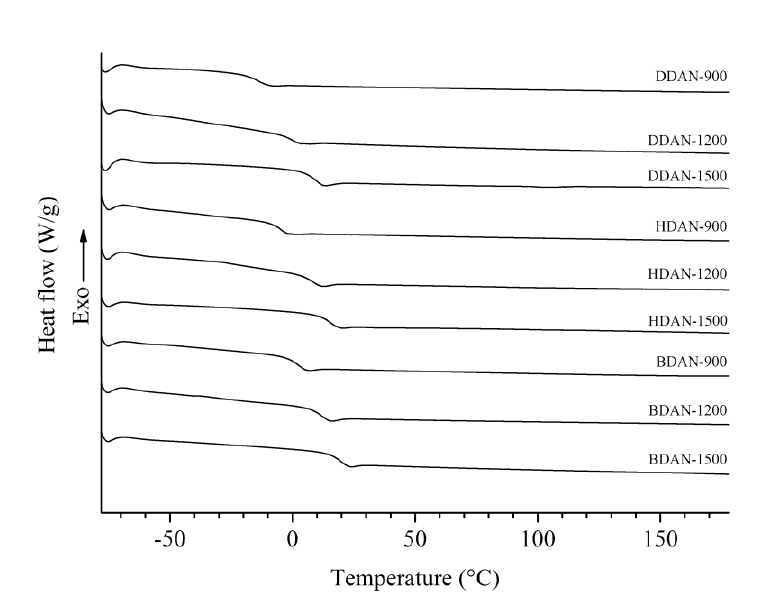
Figure 9. Differential scanning calorimetry (DSC) second heating thermograms of the neutralized OL-As. Table 5. Glass transition temperatures of OL-OHs, OL-As, neutralized OL-As, and cured inks.